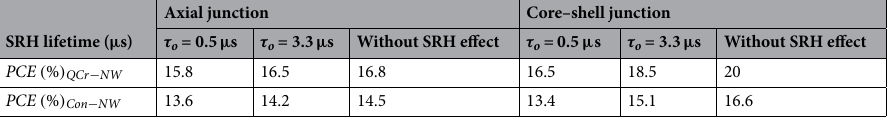
SRH lifetime ( µ s)